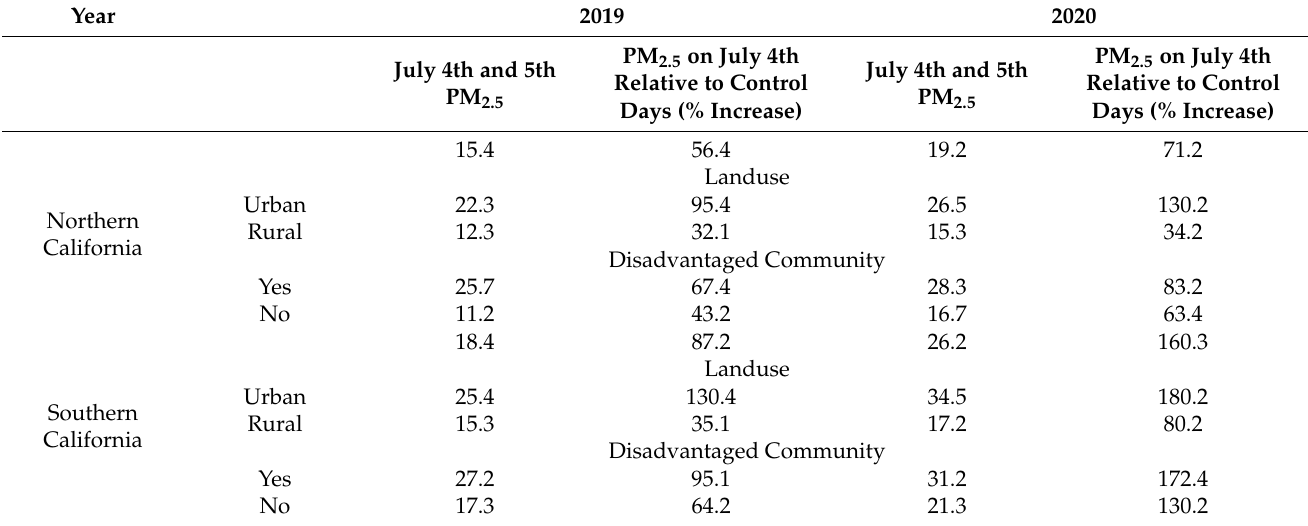
Table 2. Variation in PM 2.5 concentrations before and after firework episodes at different spatial scales, urban vs. rural areas, and disadvantaged vs. non-disadvantaged